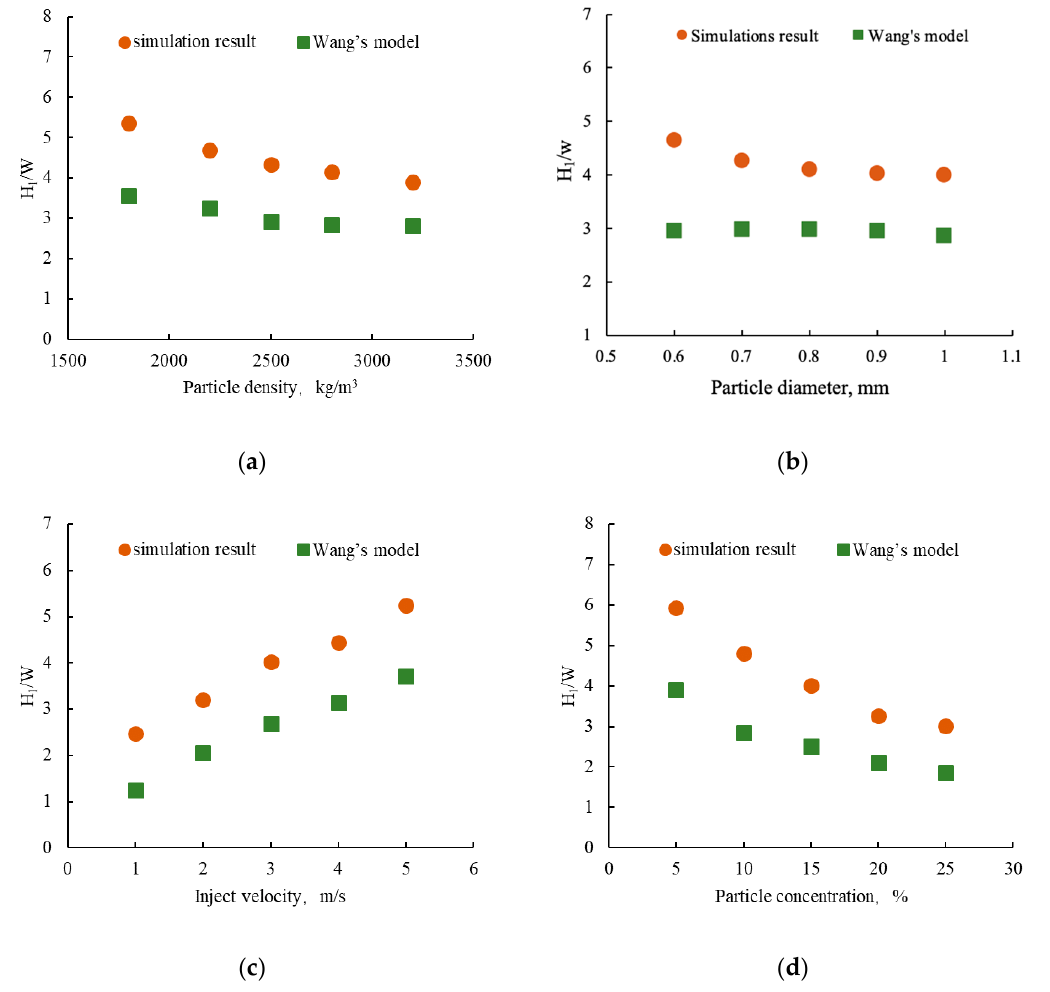
Figure 16. Comparison of the equilibrium dune height between simulation result and Wang’s model. ( a ) Comparison of particle density; ( b ) comparison of particle diameters; ( c ) comparison of injection velocity; and ( d ) comparison of particle concentration.